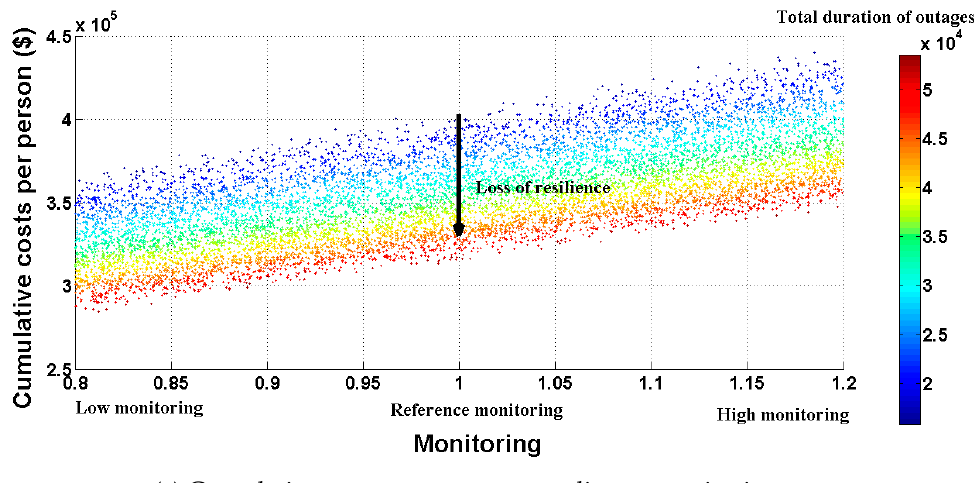
Figure 8. Influence of the different processes on the costs. ( a ) Sobol indices of the different processes. Adaptation ( b ) and monitoring ( c ) are the most influential process here, followed by the anticipation process.